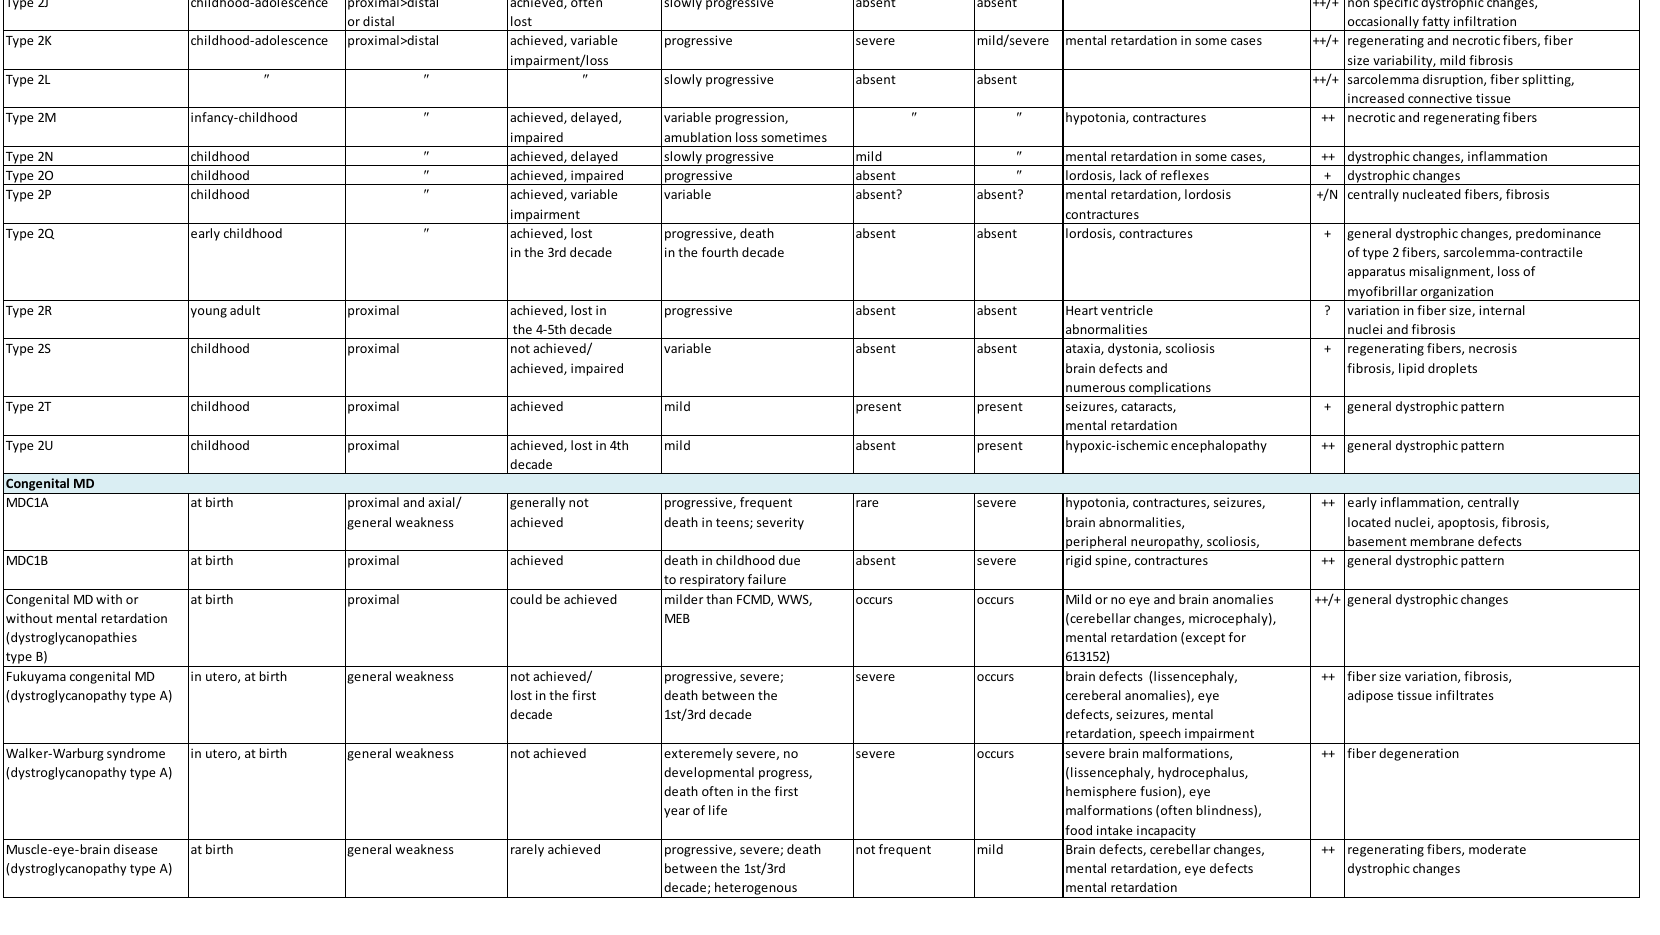
Table 2. Cont. Int. J. Mol. Sci. 2018 , 19 , x FOR PEER REVIEW 7 of